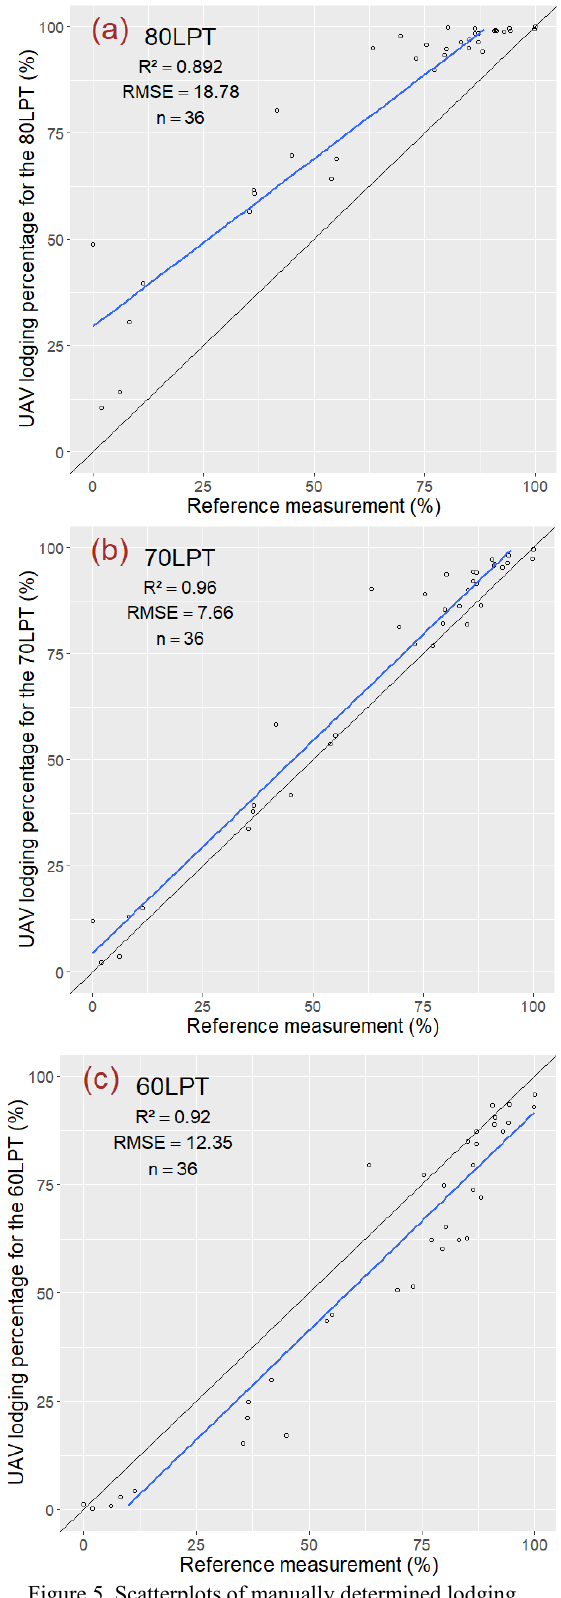
Figure 5. Scatterplots of manually determined lodging percentage (reference measurement) and calculated UAV-based lodging percentage for 80LPT (a), 70LPT (b), 60LPT (c) 75 DAS. Black line represents regression line; blue line represents 1:1 line (n = 36). LPT: lodging percentage threshold; RMSE: root mean square